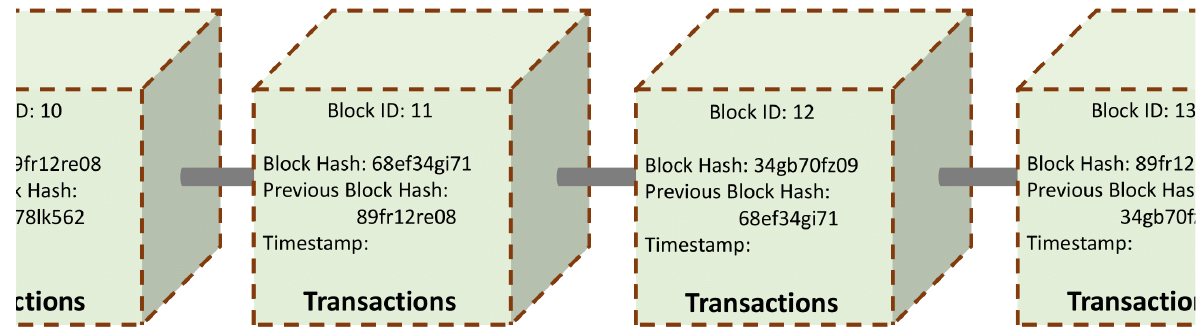
Figure 4. General structure blocks in the Blockchain concept.